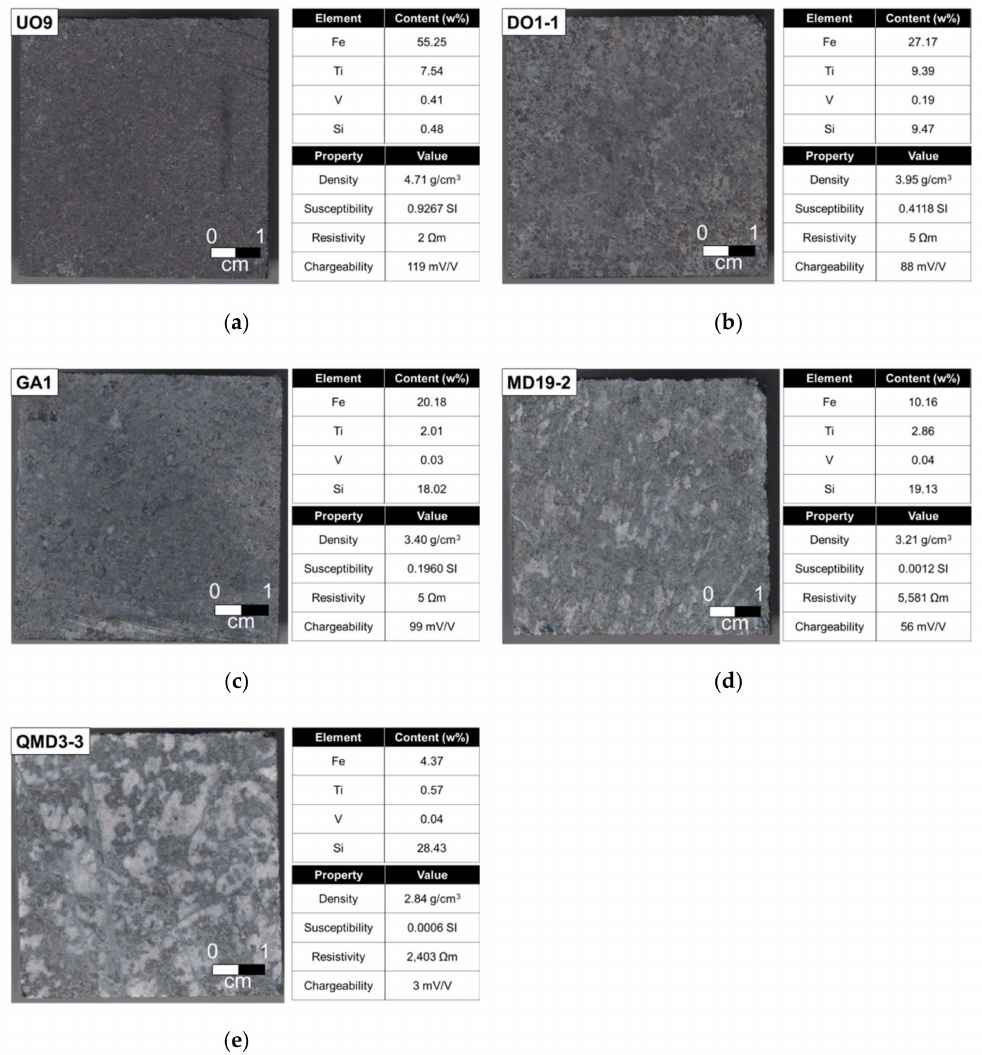
Figure 8. Rock slabs images, potable X-ray fluorescence analysis results, and geophysical prop- erties of five kinds of rock samples showing ( a ) underground ore, ( b ) discovered ore, ( c ) gabbro, ( d ) monzodiorite, and ( e ) quartz